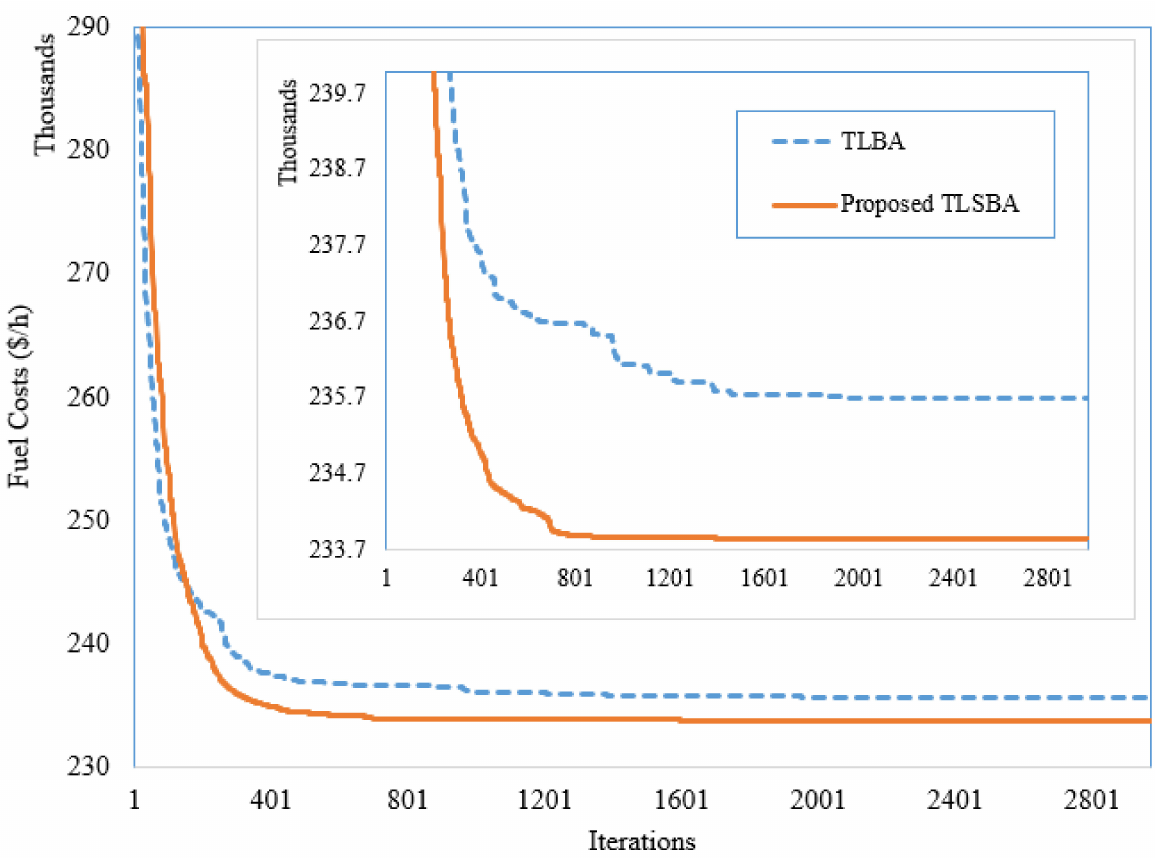
Figure 13. Convergence rates of the TLBA and the proposed TLSBA for test system